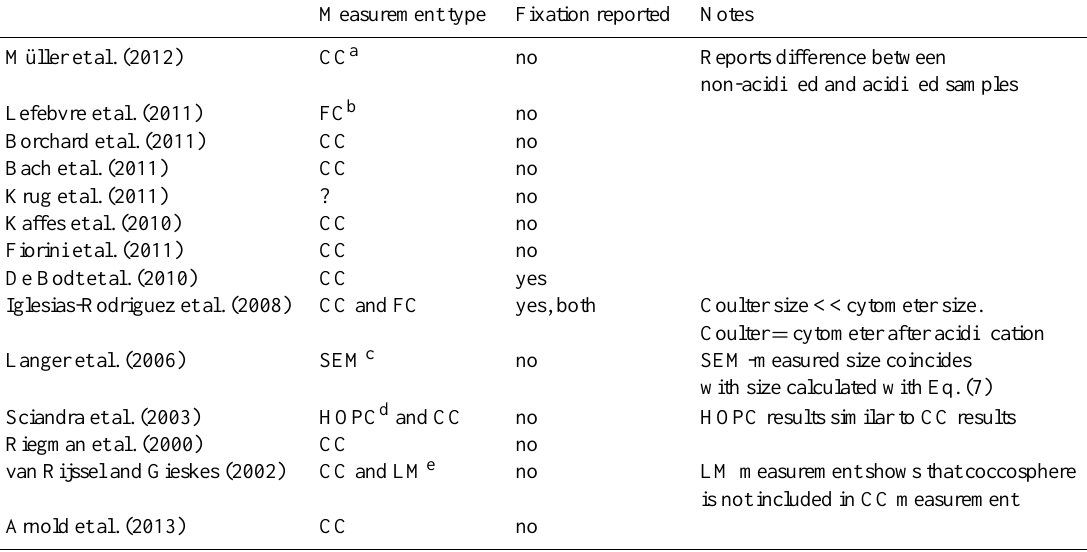
Table B1. Summary of methods used to determine the size of coccospheres in experiments included in the coccolithophore